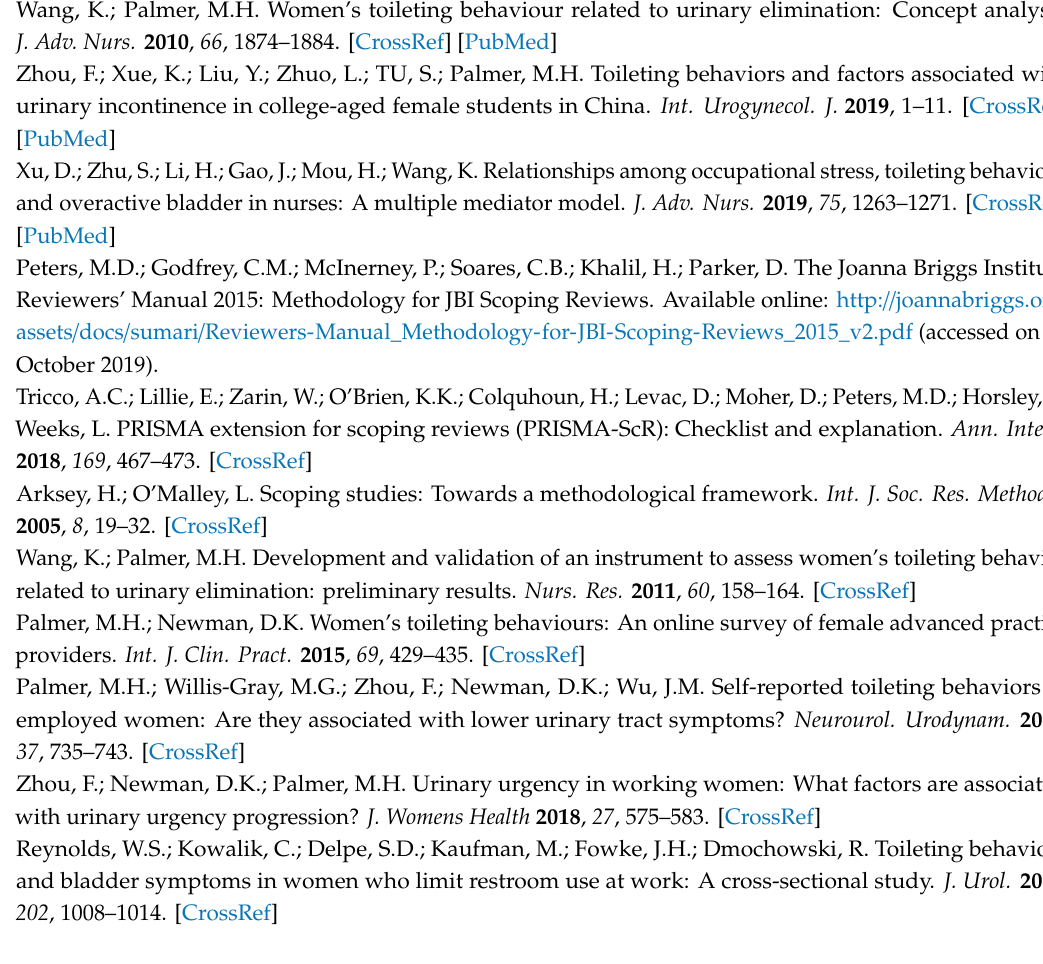
Table S1: Search strategy for each database between January 2010 and July 2019; Table S2: Basic characteristics of the 25 included